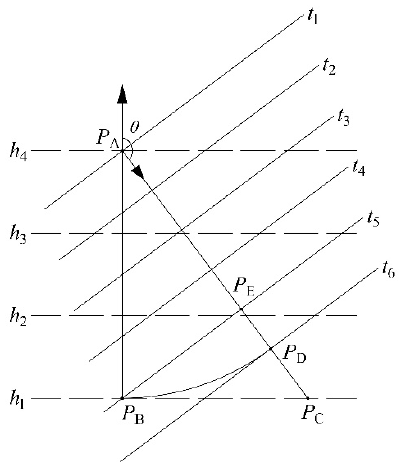
Figure 1. Contour of homogeneous height field (dashed line) and temperature field (solid line). Contour lines of the height field and the temperature field are given as h and t , respectively ( h 1 < h 2 < h 3 < h 4 , t 1 < t 2 < t 3 < t 4 < t 5 < t 6 ). The northward and southeastward arrow show the direction of the gradient of height and temperature, respectively. P A , P B , · · · , P E represent the geographical positions on a two-dimensional map. The arc between P B and P D is part of a circle centered on P A . In digital image processing, height field and temperature field are both discrete, and the gradient can be obtained through image enhancement techniques [47]. Three of the most common operators, Roberts, Prewitt, and Sobel, are used in edge-detection (a kind of image enhancement), and the